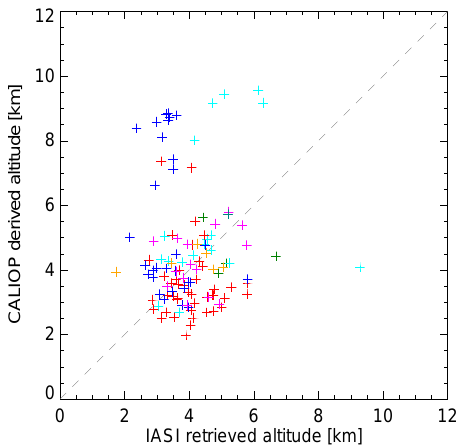
Figure 10. The results of comparisons between the retrieved IASI altitude and the derived CALIOP plume height for all scenes dur- ing the the Eyjafjallajökull eruption. The different colours indicate different